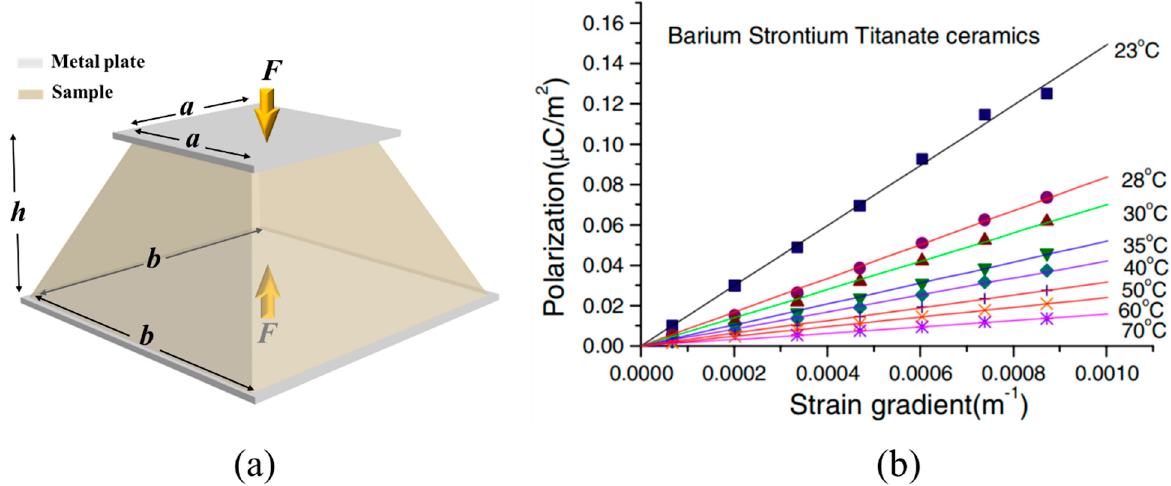
Figure 5. ( a ) Schematic of pyramid compression method used to apply strain gradient. ( b ) Depen- dence of polarization on strain gradient for an unpoled BST sample measured using the PC test at different temperatures. Reprinted with permission from [1]. Copyright 2006 Springer Science Business Media,